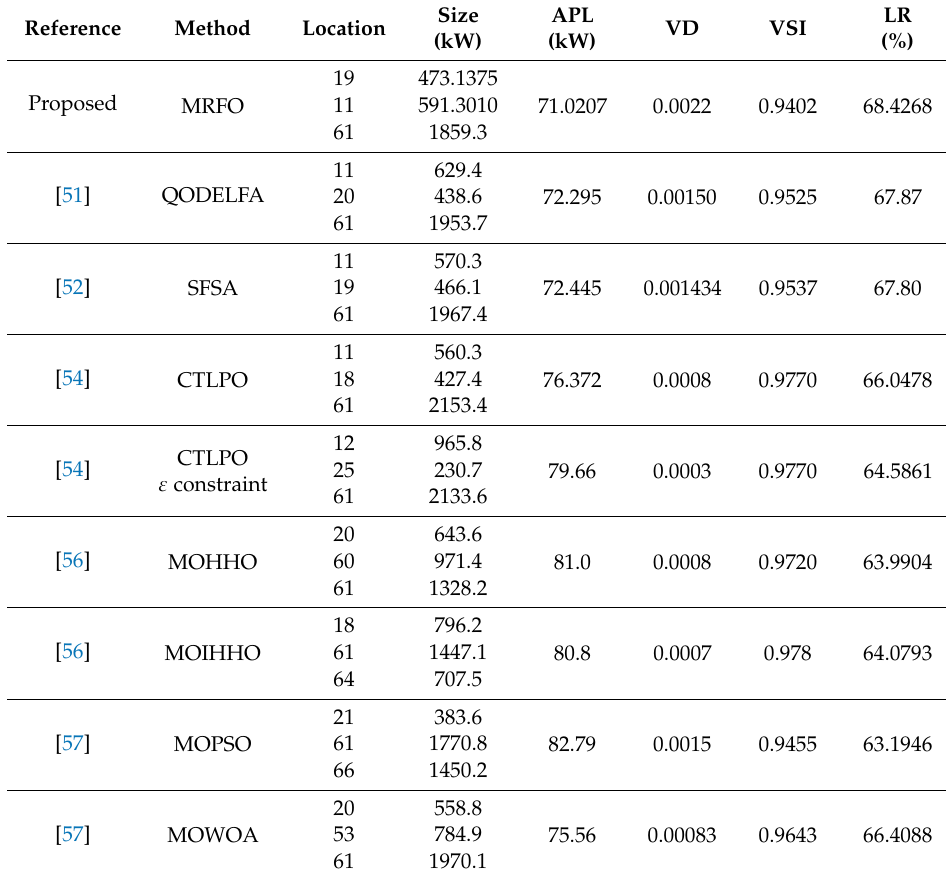
Table 6. 69-bus system, three DG units at unity Power Factor (PF)